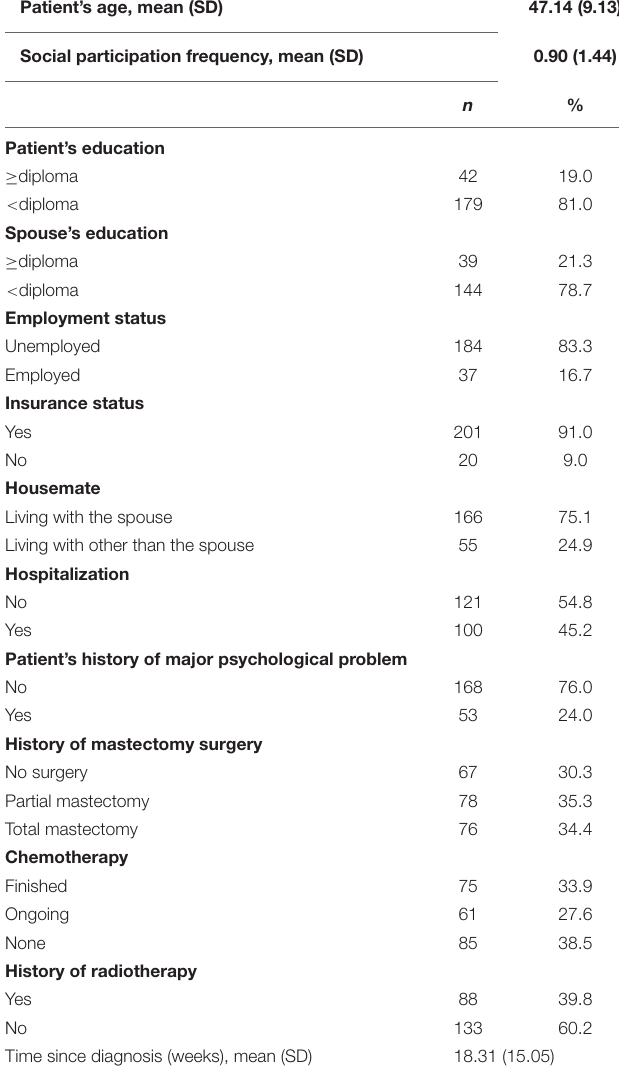
TABLE 1 | Sample characteristics ( N =